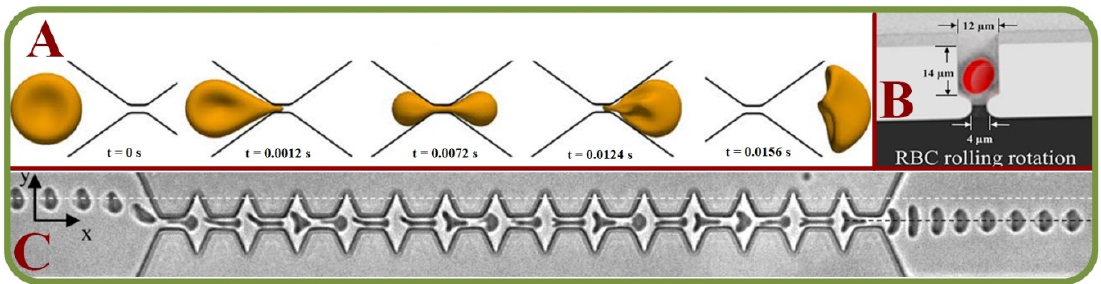
Figure 6. Single RBC trapping arrays. ( A ) Boundary simulations of a RBC squeezed through a submicron slit under prescribed inlet and outlet pressures [93]; ( B ) Independent and grouped single RBC rotations in a microwell for bioimaging applications [94]; ( C ) Microscopic images showing the shape recovery of single RBCs flowing out of a microfluidic constriction [92].